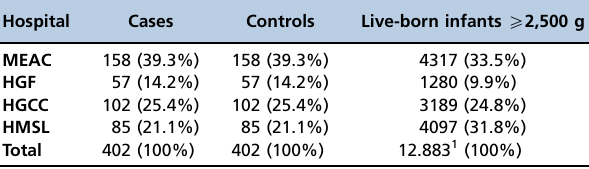
Table 1 - Distribution of the infants included in the study among the 4 reference maternity hospitals. Hospital